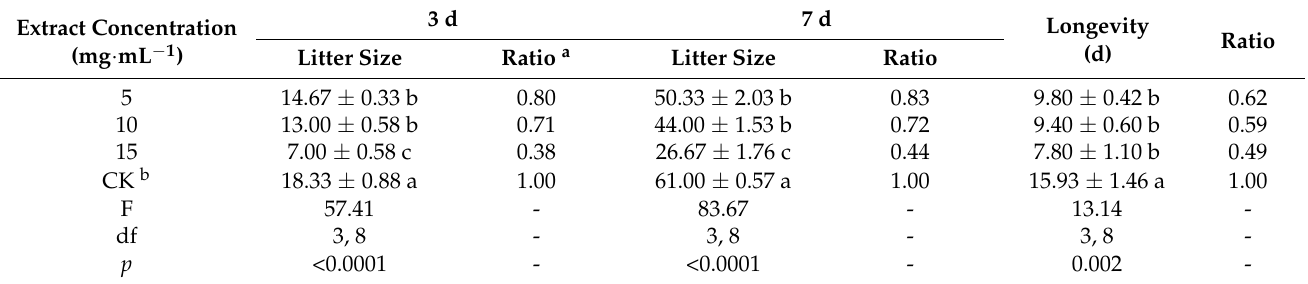
Table 4. Mean litter size and longevity ( ± SE) of M. sorghi after treatment with different concentrations of GSE, and the data of litter sizes were taken from 3 d and 7 d